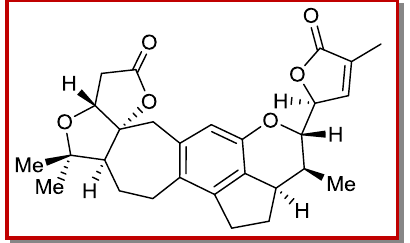
Figure 1 : Structure of rubriflordilactone